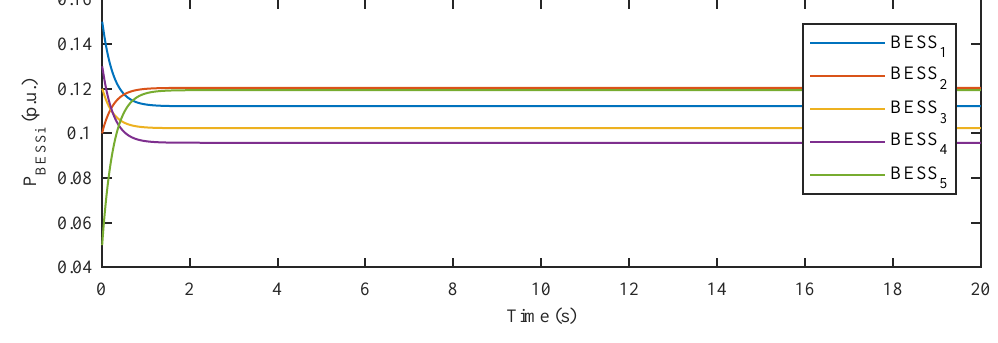
Figure 13. Power output of BESSs. Table 4. Performance comparison from the initial state.